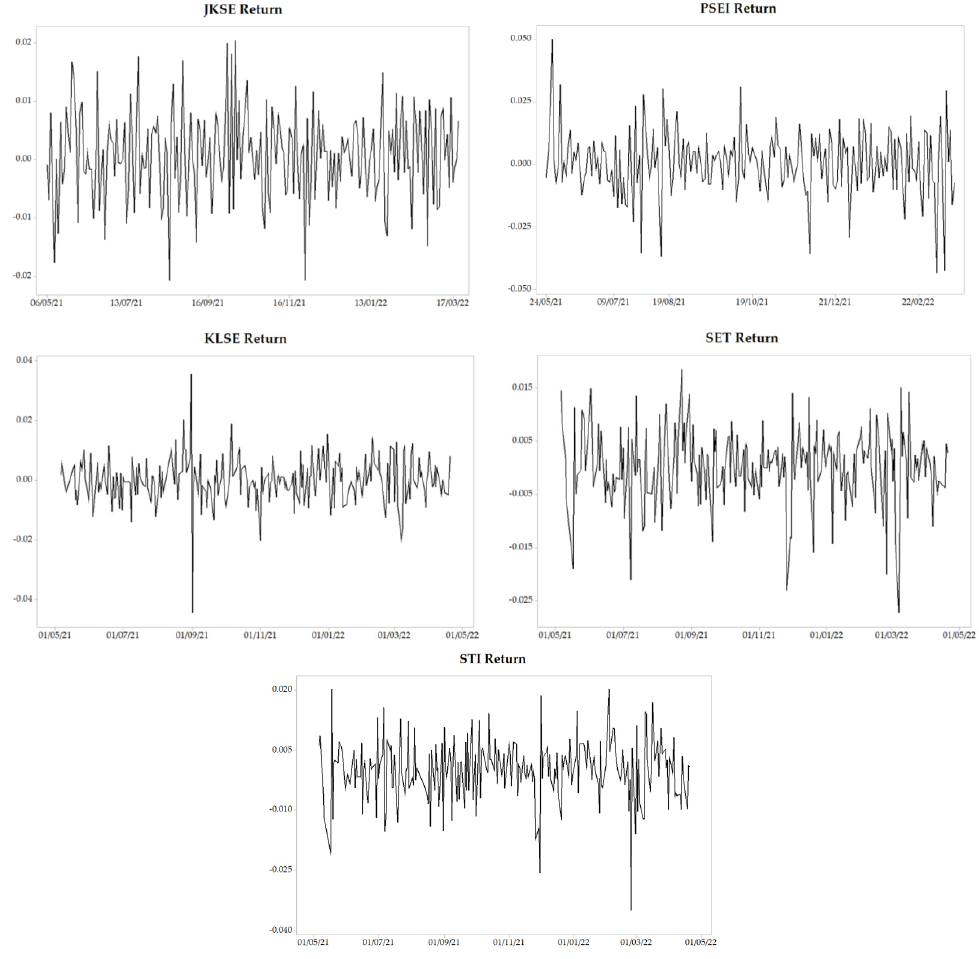
Figure 1. ASEAN-5 stock price index returns.